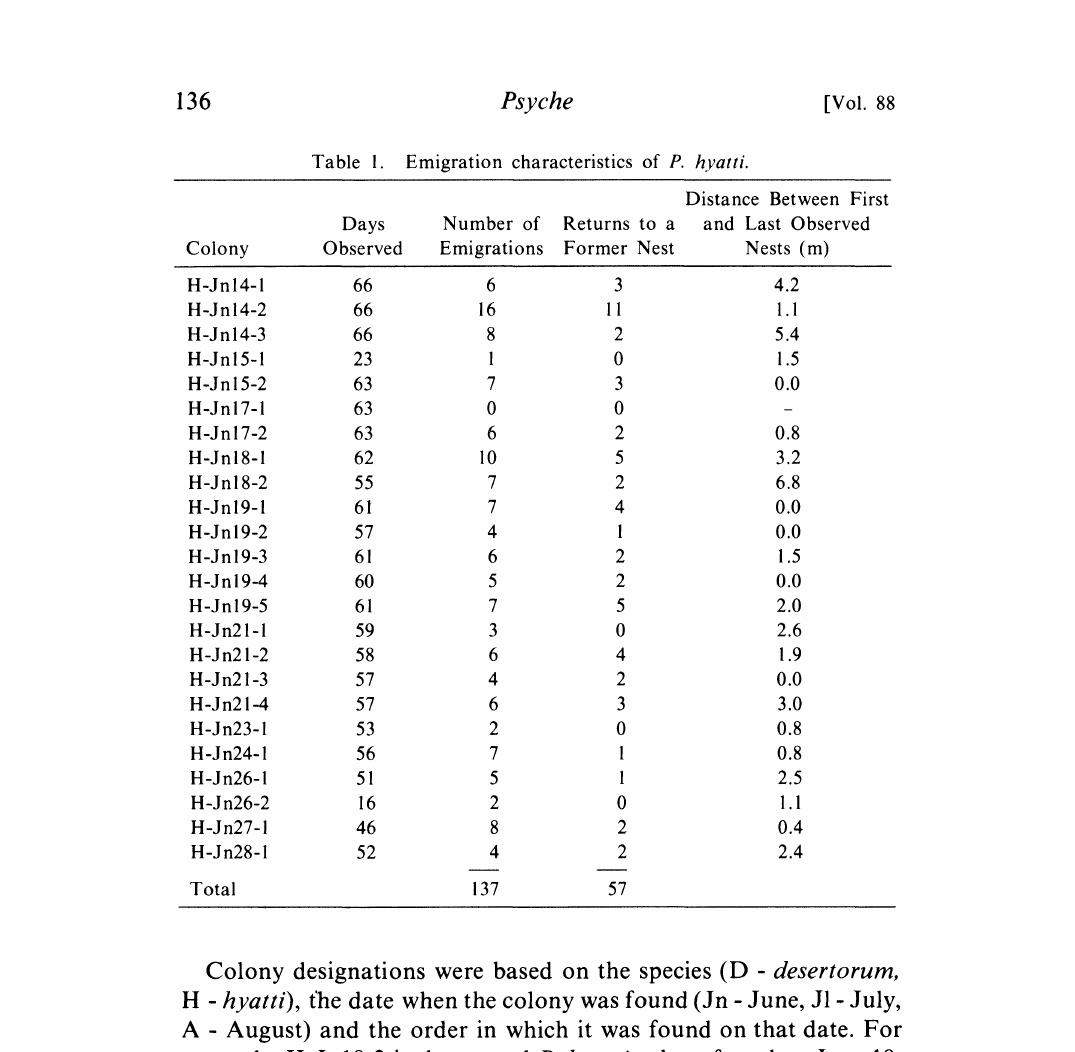
Table 1. Emigration characteristics of P.